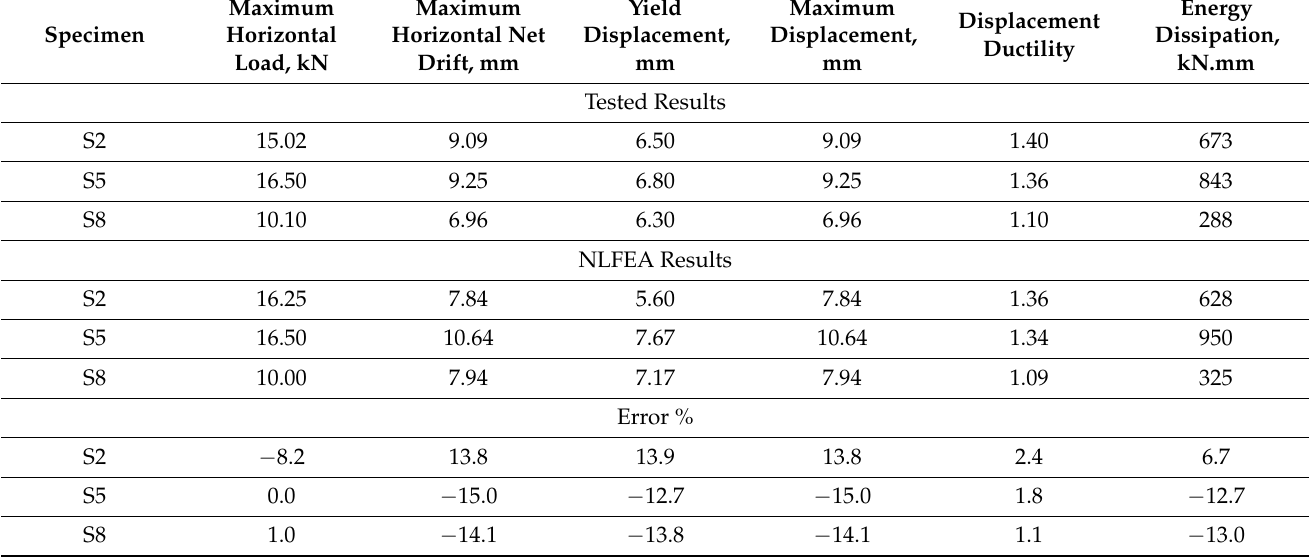
Table 2. NLFEA and Tested results